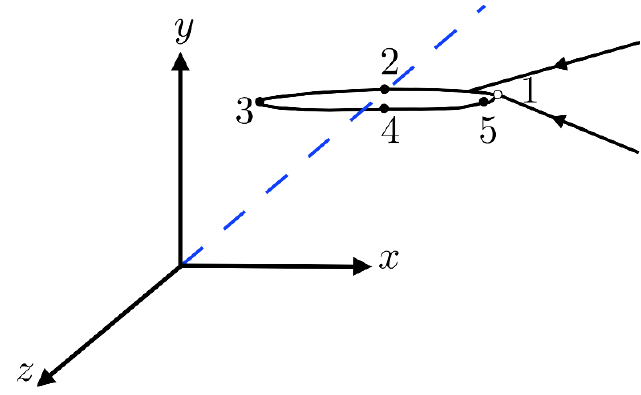
Figure 2 . Aharonov-Bohm trajectory where a charged particle (solid line with arrows) encircles a (Dirac) string (dashed line) which lies along the negative z -axis, with the monopole at the origin. A time-ordered sequence of points is labeled 1-5.